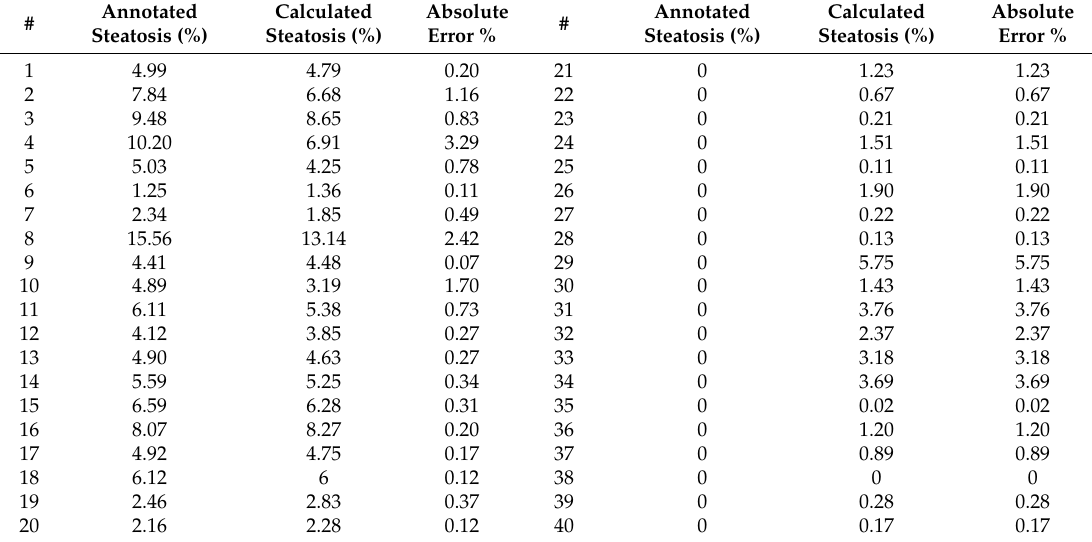
Table 2. Annotated and Calculated Steatosis (%), and Absolute Error